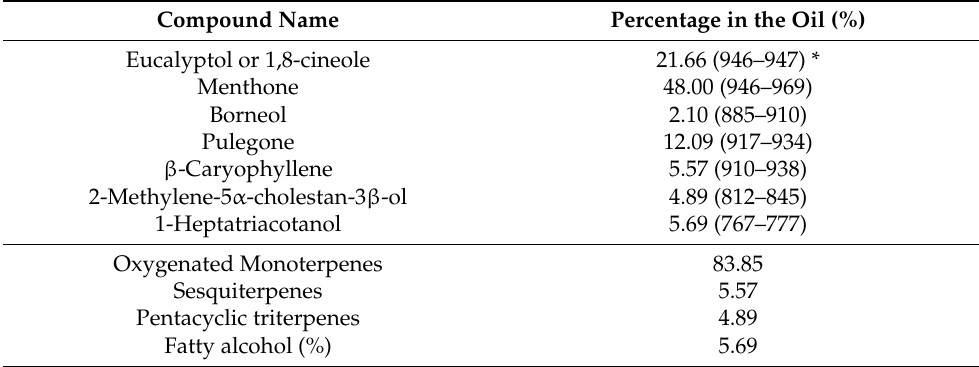
Table 1. Chemical composition of the essential oil from Mentha longifolia aerial parts.